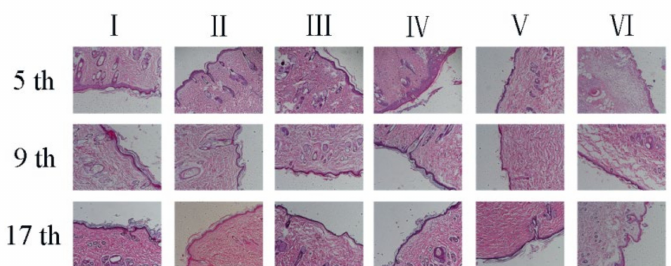
Figure 11. Hematoxylin and eosin (H&E) stained microscopic sections of healed incisions in rats. (( I ) PNIPAAm-PVA/CS-CuS with illumination, ( II ) PVA/CS hydrogels-PVA/CS-CuS with illumi- nation; ( III ) PNIPAAm-PVA/CS-CuS without illumination; ( IV ) PVA/CS nanofiber membrane; ( V ) PNIPAAm-CuS hydrogels; ( VI ) treated with sterile